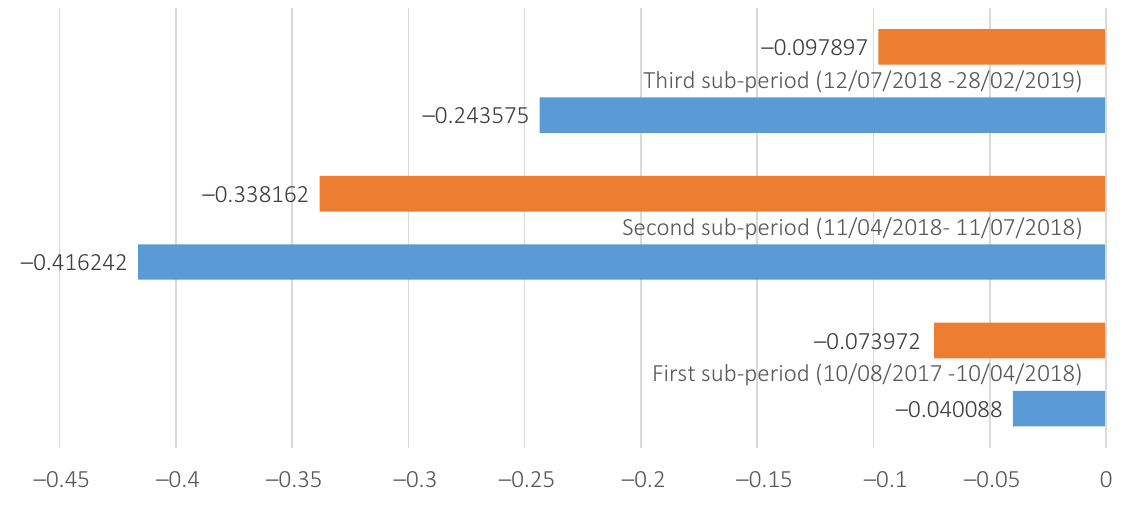
Figure 3. The coefficient of ETC ( )